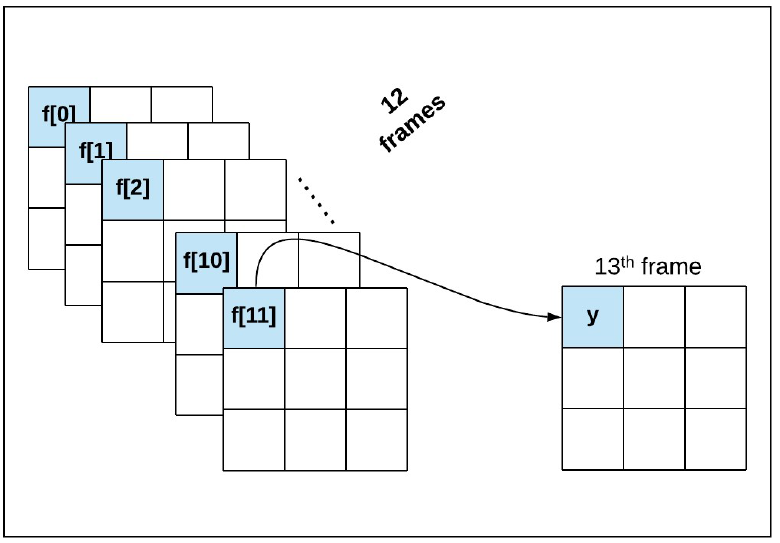
Figure 5. Overview of dataset preparation: Notation for same-pixel features used in image